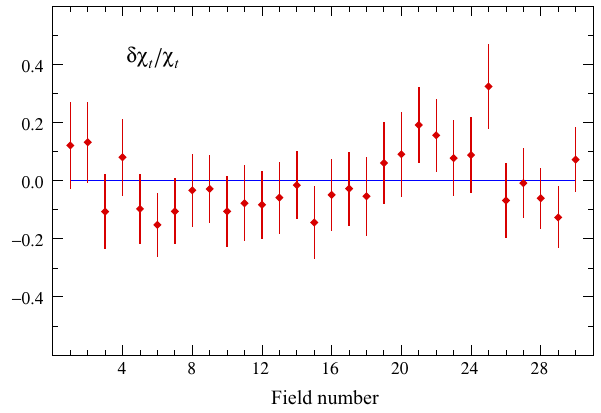
Fig. 5 Relative deviation from the ensemble average of the values of the topological susceptibility computed using single master fields (run A 3 , flow time 0 . 97 t 0